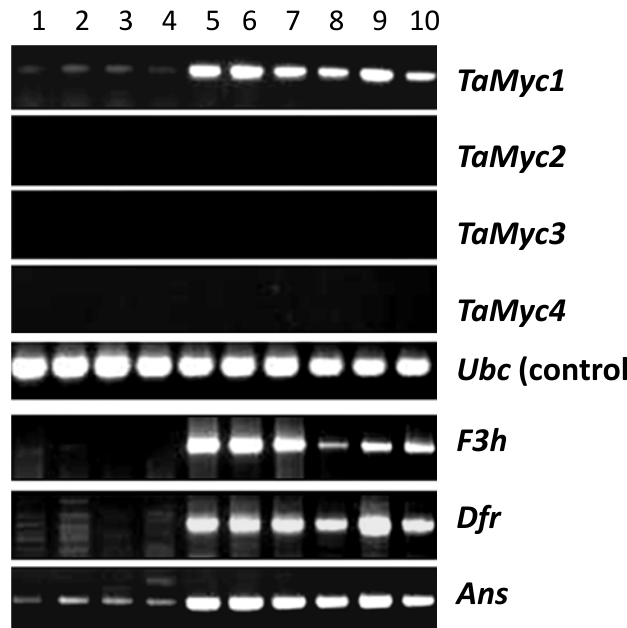
Figure 3. Transcription of the Myc gene copies in the pericarp of cv. “Novosibirskaya 67” ( 1 ); cv. “Saratovskaya 29” ( 2 – 4 ); “i:S29 Pp-A1Pp-D1Pp3 P ” NIL ( 5 – 6 ); “i:S29 Pp-A1Pp-D1Pp3 PF ” NIL ( 7 , 8 ); cv. “Purple” ( 9 ) and cv. “Purple Feed” ( 10 ).